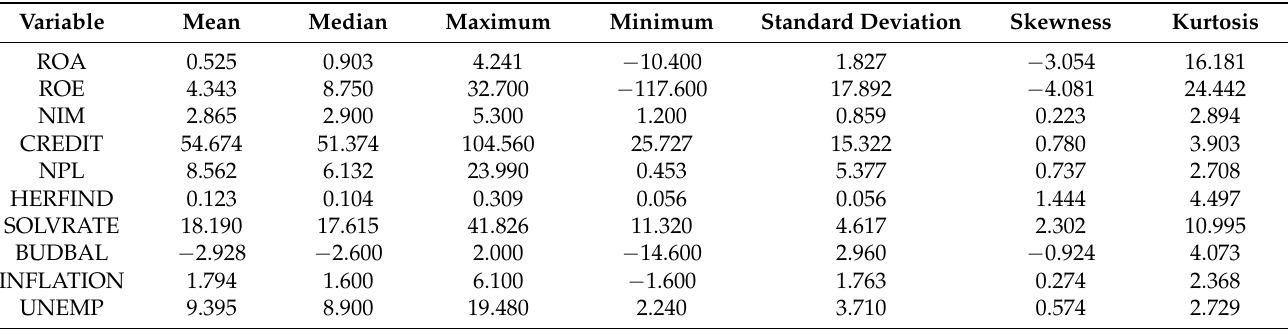
Table 2. Descriptive statistics of variables, full